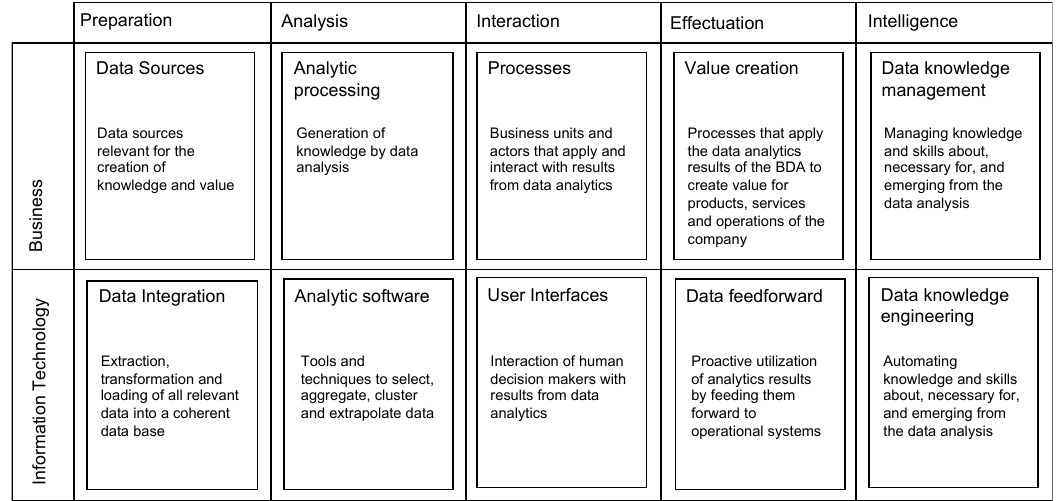
Figure 4. Big data management canvas [7,8]: According to the theory of Business intelligence as a cognitive system in Figure 3, the aspects of data preparation, analysis, interaction, effectuation, and intelligence align both business and IT fields of action to create value from data.